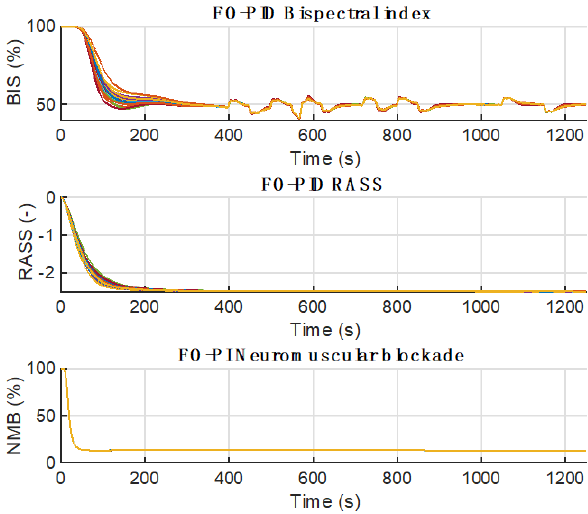
Figure 14. Final BIS, RASS and NMB responses of general anesthesia—simulation results with the proposed fractional-order switching function on all 24 patients.